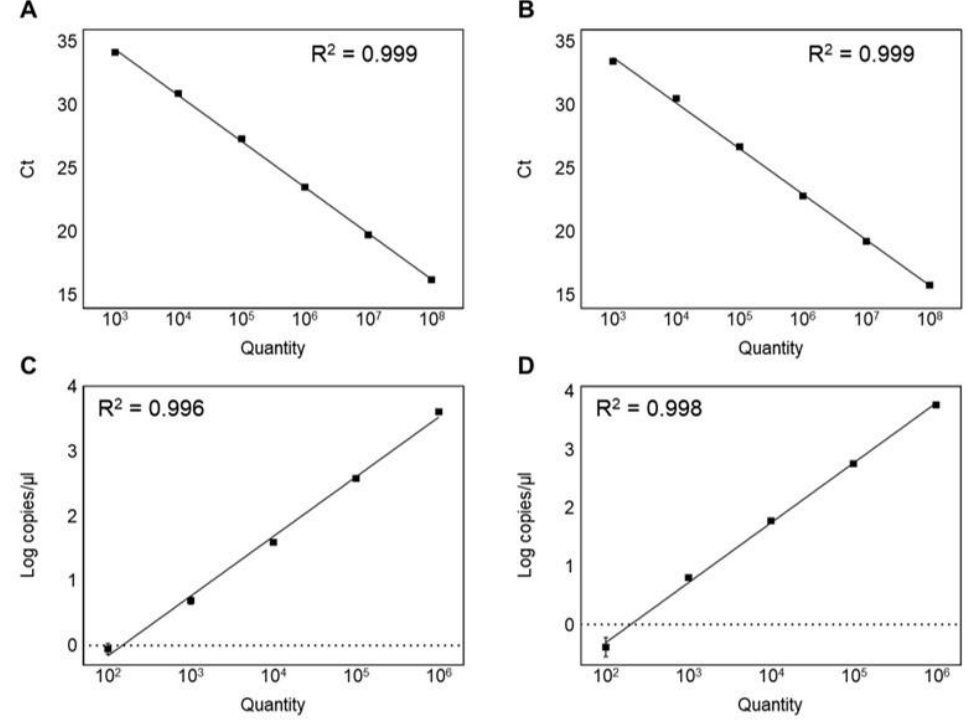
Figure 3. Linearity and sensitivity of two assays. ( A ) qPCR in analyzing genomic DNA of L . planta- rum subsp. plantarum KACC 11451; ( B ) qPCR in analyzing spiked milk sample; ( C ) ddPCR in analyzing genomic DNA of L . plantarum subsp. plantarum KACC 11451; ( D ) ddPCR in analyzing spiked milk sample.